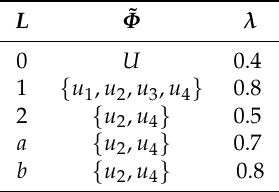
Table 2. Tabular representation of the hybrid structure ˜ Φ λ